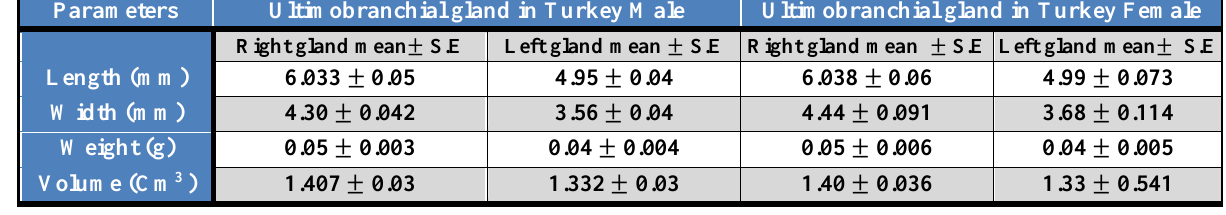
Table, 3: Dimensions of Ultimobranchial gland in the Male and Female of local breed Turkey Meleagris gallopavo .